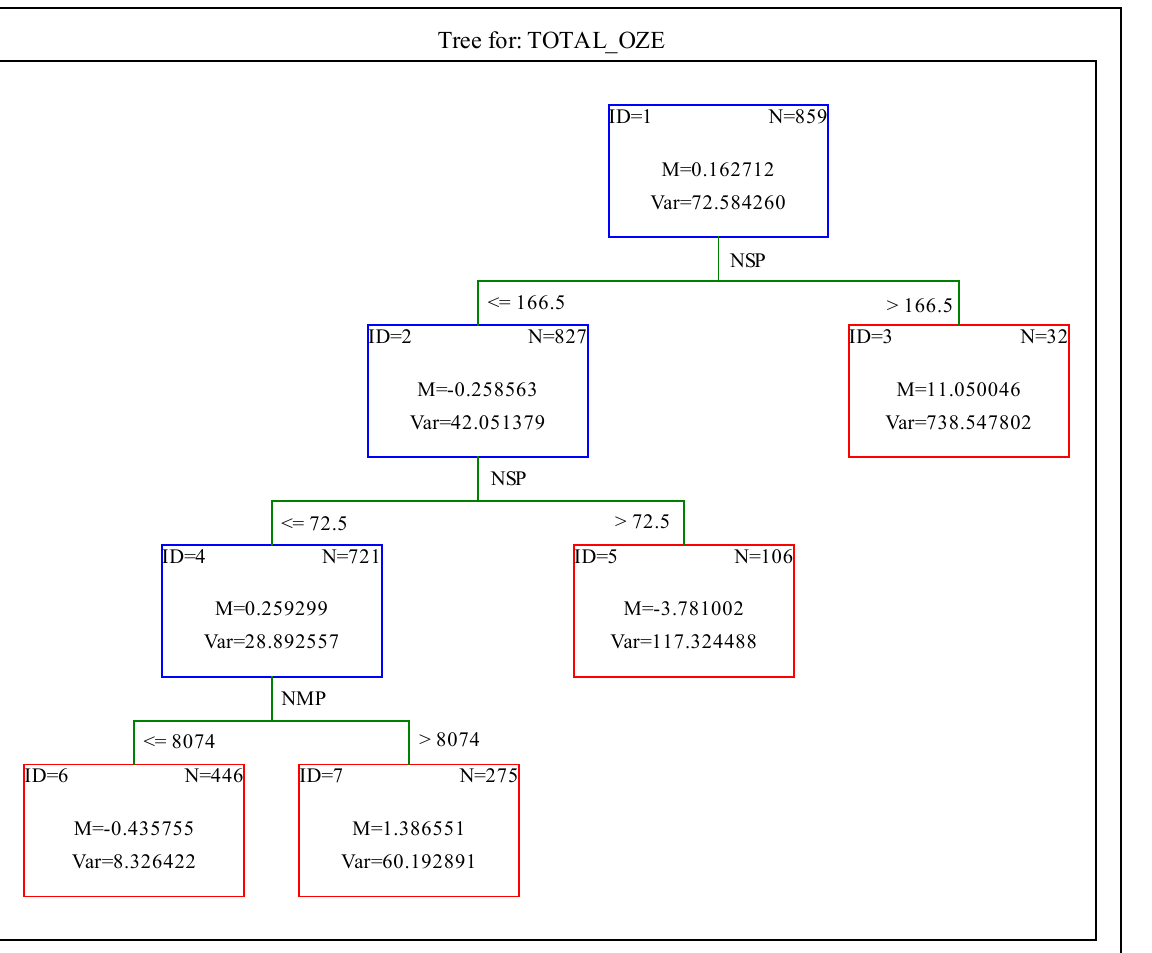
Figure 3. Example of classification result for a variable TOTAL_OZE.